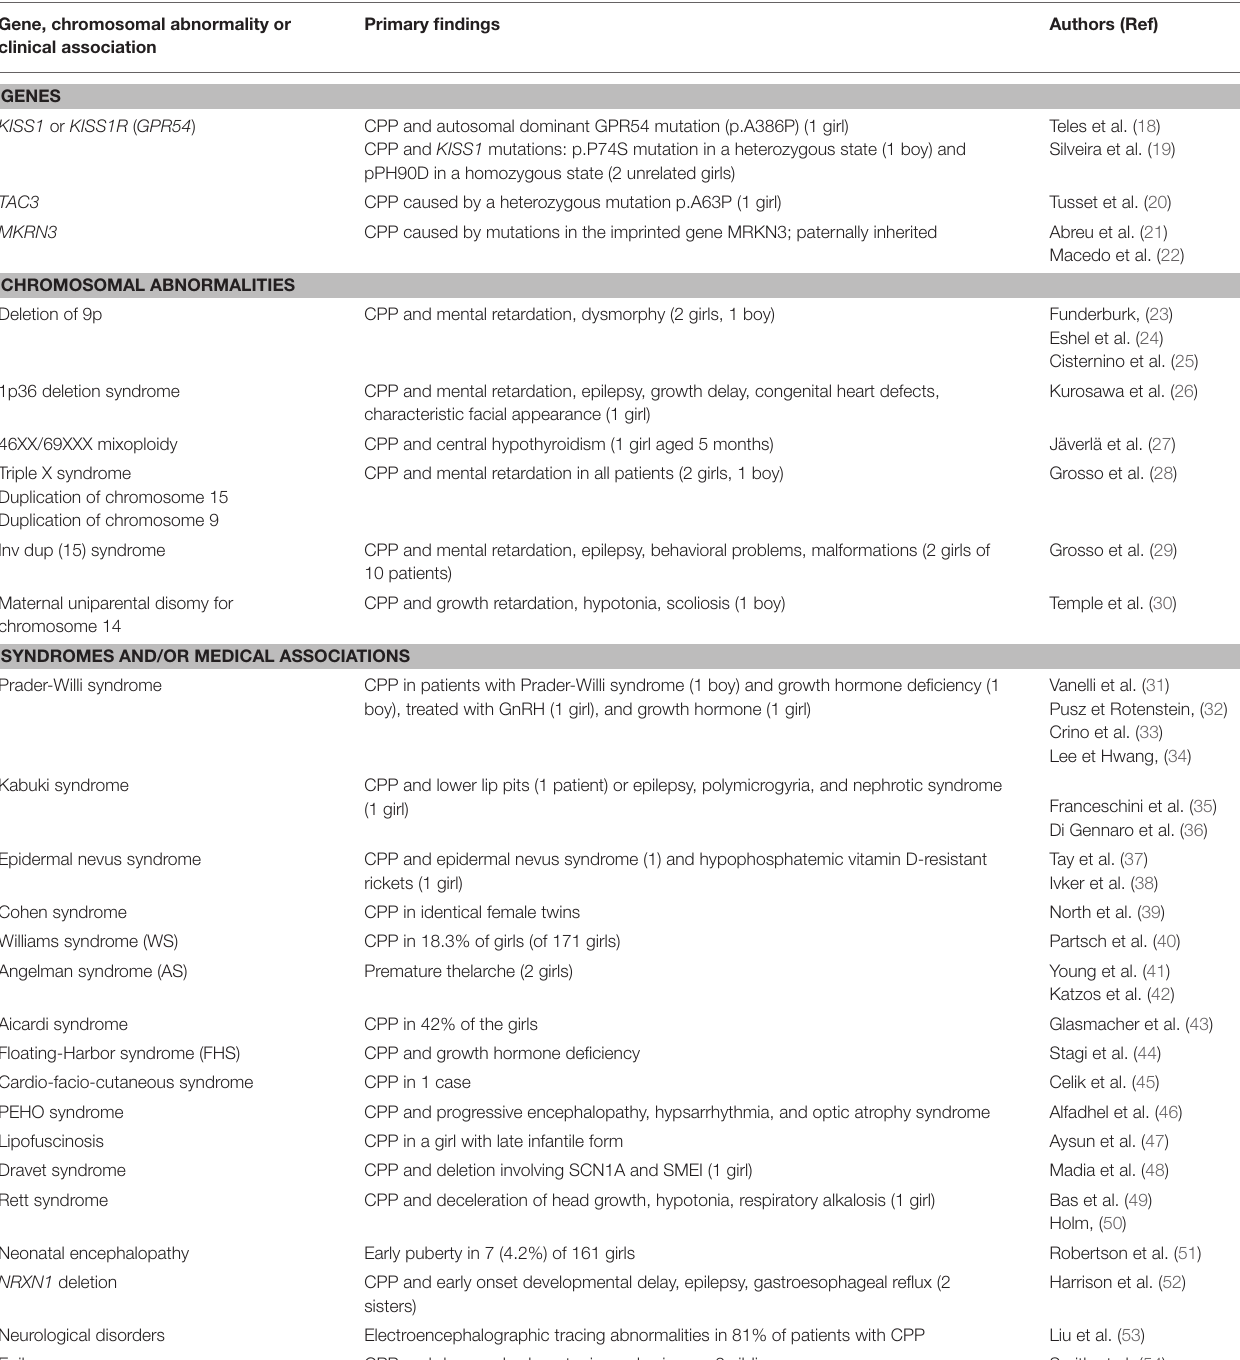
TABLE 3 | Reported data related to genetic factors and various disorders associated with precocious or early puberty. Gene, chromosomal abnormality or clinical